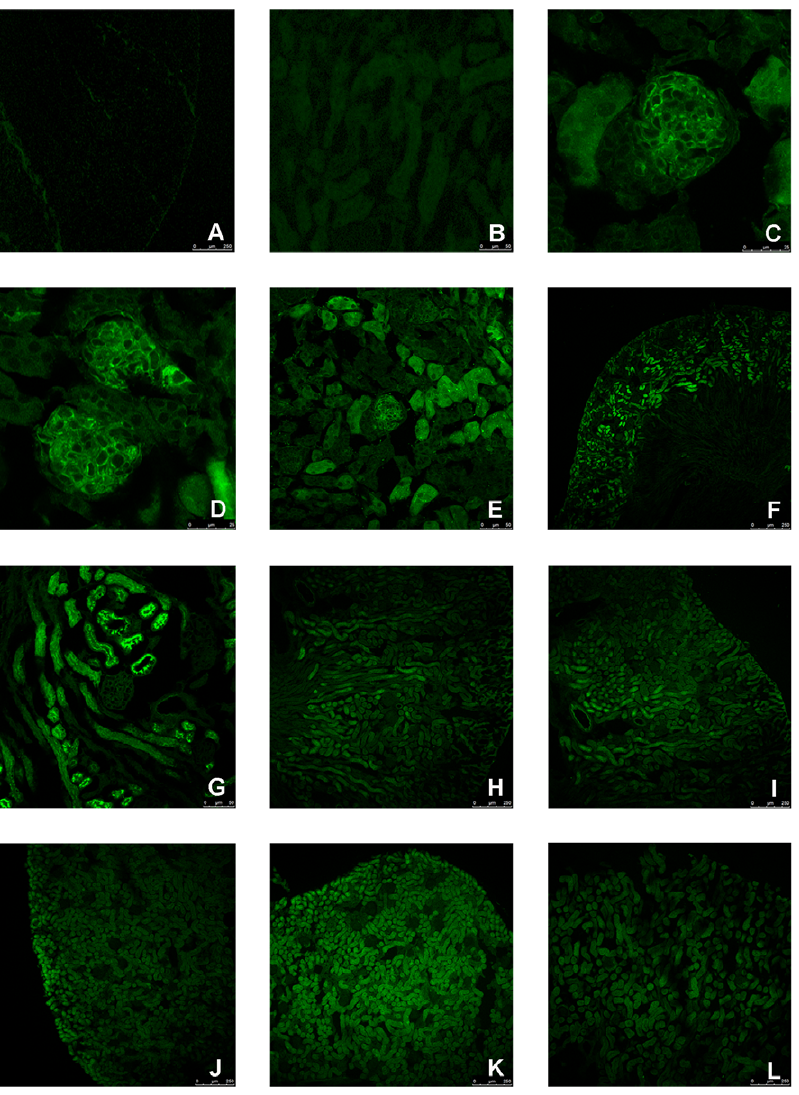
Figure 1. Localization of EPOR during mouse kidney cortex postnatal development. The negative control was shown in (A, B). The expression of EPOR in the mouse kidney cortex could be detected at P7 (C). Suspected Immature corpuscle could be observed at P7 (D). The expression of EPOR was higher at tubule part, and the expression at corpuscle part was almost undetectable at P14 (G). The expression of EPOR was detected in the kidney cortex at P7 (E), P14 (F), P21 (H), P28 (I), P35 (J), P42 (K) and mature mouse